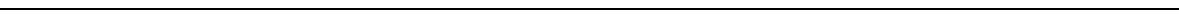
Fig. 1 FBXO32 is an essential regulator of phenotypic and transcriptional changes that are hallmark of EMT. a Schematic representation of in vitro EMT induction and the identi fi cation of previously unknown regulators. b Using RT-PCR, the levels of Fbxo32 mRNA in NMuMG cells during TGF- β -induced EMT were measured relative to Ctcf and plotted on the y -axis. c FBXO32 mRNA level was measured by RT-PCR in primary human breast epithelial cells (HMEC) undergoing TGF- β -induced EMT as described in Fig 1b. d , e Western blot analysis of FBXO32 in mouse NMuMG cell ( d ) and human HMECs ( e ) undergoing TGF- β -induced EMT. Lamin and β -Actin acted as a loading control. f Representative bright- fi eld and immuno fl uorescence images showing the localization and expression levels of EMT marker proteins after 4 days (d4) of siRNA-mediated depletion of FBXO32 compared to non-targeting control (siControl) in NMuMG cells. Staining was performed to assess the expression with antibodies against the epithelial markers E-cadherin and ZO1, the mesenchymal marker N-cadherin, Fibronectin-1, Phalloidin (to visualize the actin cytoskeleton) and Paxillin (to detect focal adhesion plaques). Scale bar, 100 μ m. g , h Using RT-PCR, the levels of FBXO32 and key EMT markers in NMuMG g and HMEC h cells transfected with either control siRNA or independent siRNAs against FBXO32 during TGF- β -induced EMT were measured relative to CTCF and plotted on the y -axis. All experiments were performed in biological triplicates unless otherwise speci fi ed. Error bars represent the SEM of three independent biological replicates ( n = 3). * p < 0.05, ** p < 0.01, *** p < 0.001, Student ’ s t test. See also Supplementary Figs. 1 –